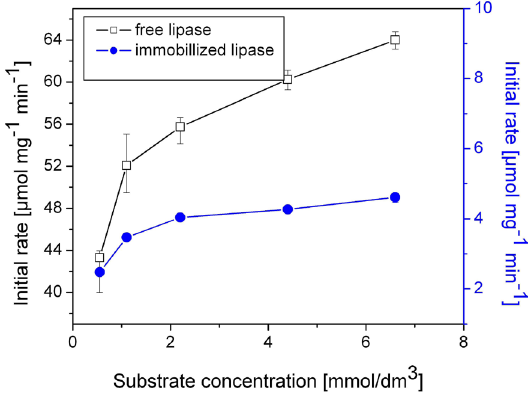
Figure 14. The effect of the substrate concentration on the initial velocity at 28°C: free lipase (left y-axis) and lipase immobilized onto mesoporous silica layer (right y-axis).